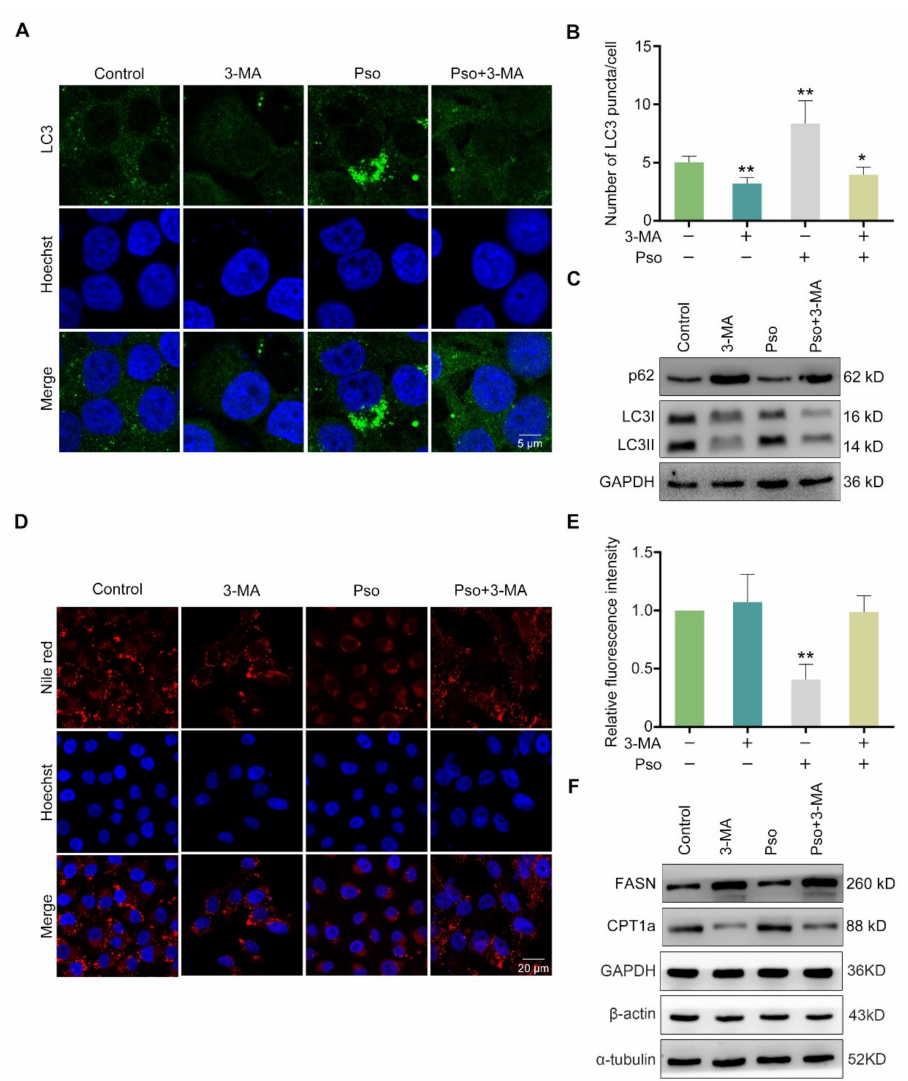
Figure 6. Psoralen promotes the initiation of autophagy. Sodium oleate-induced L02 cells were treated with psoralen (3.3 µ M) alone or in combination with 3-MA (10 mM) for 24 h. ( A ) L02 cells were stained with the anti-LC3 antibody and Hoechst 33258 as detected by confocal microscopy (scale bar = 5 µ m). ( B ) Quantification of LC3 puncta per cell. ( C ) The expression of p62, LC3I,